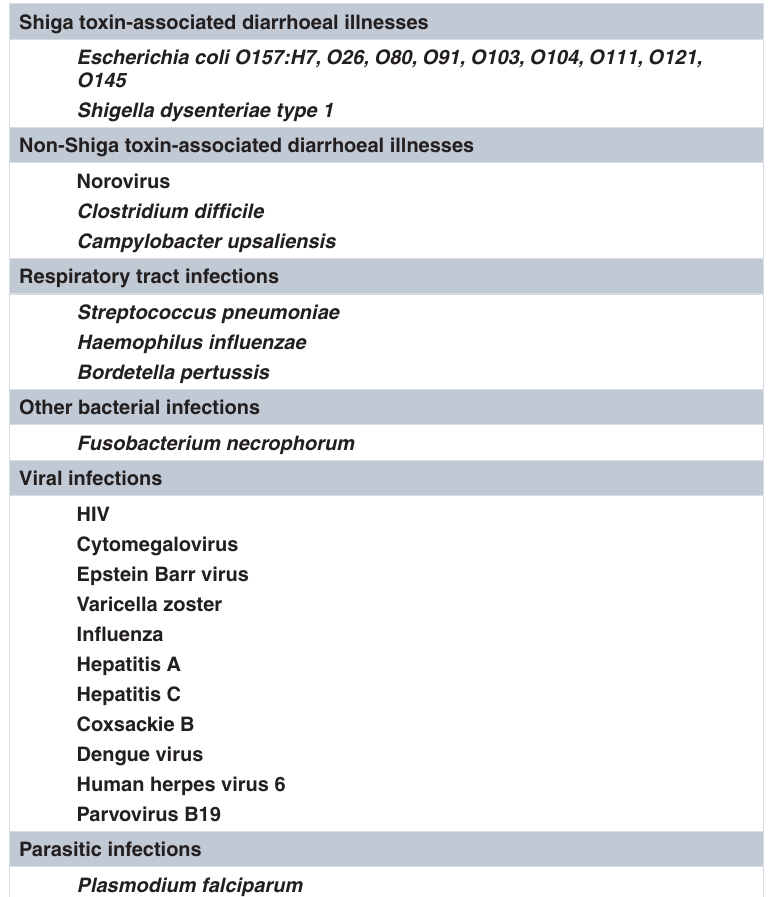
Table 1. Infections associated with the development of a thrombotic